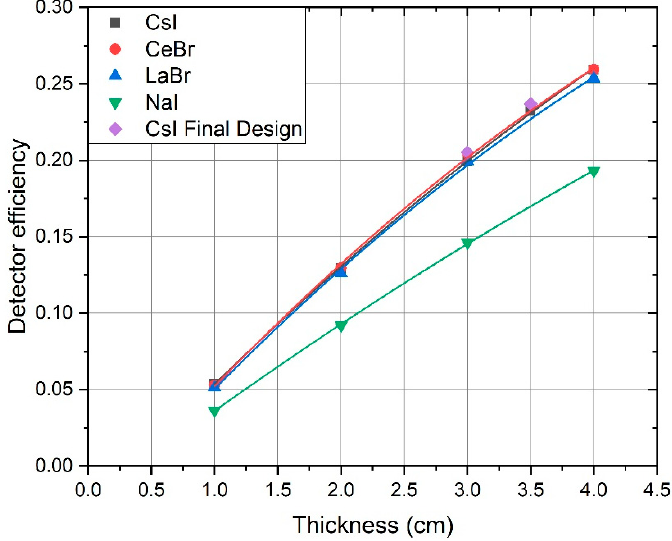
Figure 4. Results of Monte Carlo simulations using Penelope (2018). Different detector materials and geometries with a mass of 1 kg (all except Final Design) compared to the full energy peak efficiency of the combination of the two main gamma peaks of Co-60 (1173 keV and 1332